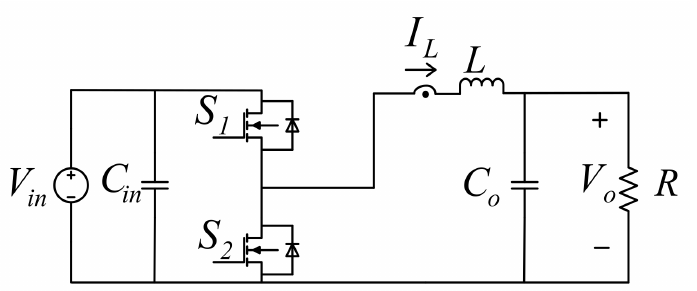
Figure 6. Configuration of synchronous buck